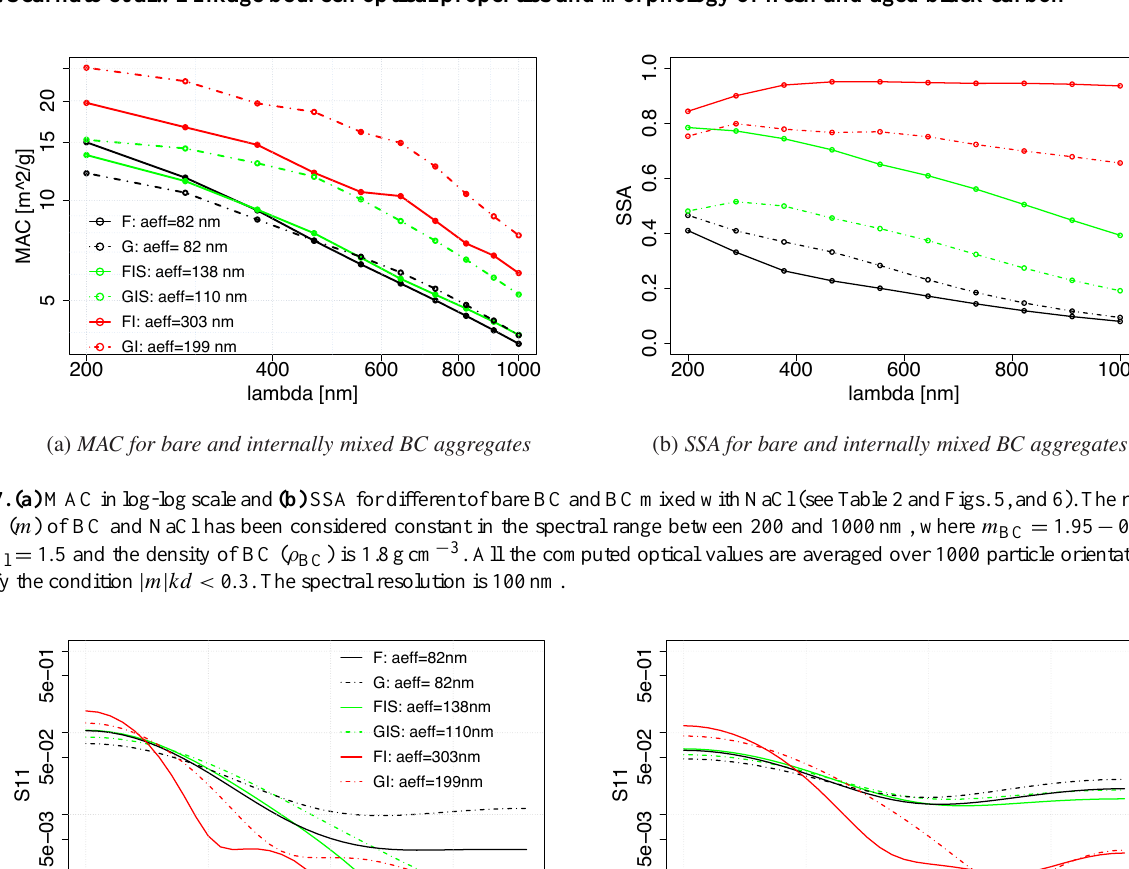
Fig. 7: (a) MAC in log-log scale and (b) SSA for different of bare BC and BC mixed with NaCl (see table 2 and Figures 5, 6). The refractive index ( m ) of BC ans NaCl has been considered constant in the spectral range between = 1 . 95 0 . 79 i and m = 1 . 5 and the density of BC ( ρ 200 and 1000 nm, where m BC NaCl − the computed optical values are averaged over 1000 particle orientations and satisfy the condition The spectral resolution is 100 nm.